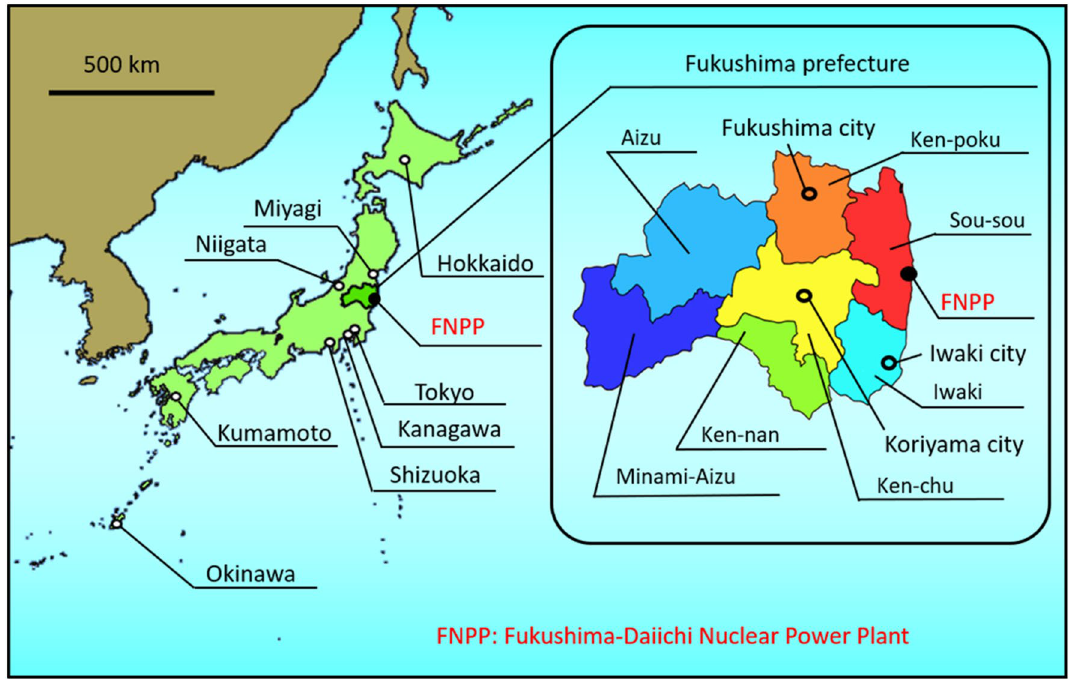
Figure 1. Locations of prefectures and seven administrative districts in Fukushima where deciduous teeth were collected. The maps were modified from open-access base maps freely available for public and academic use (source: https:// maps. gsi. go. jp/, from the Geographic Information Authority of